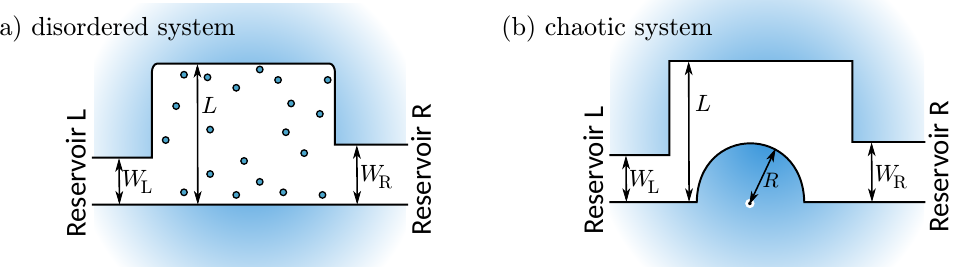
The systems we consider in this work are those described by random matrix theory, this could be (a) a disordered system or (b) a chaotic system (such as a Sinai billiard). In both cases, the system is coupled to two reservoirs (left and right) through leads with N and N modes respectively. The number of lead modes L R + N N for a lead of width W is given above Eq. (12b). We define N = N , and i i L R consider the properties of the ensemble of such systems for N (cid:29) 1, as modelled by an ensemble of random matrices. In the case of the disordered system, this ensemble corresponds to the ensemble of systems with the disorder in different positions. In the case of chaotic systems, this ensemble corresponds to an ensemble of shapes of the potential; for the Sinai billiard, such an ensemble can be found by varying the radius R over a range much larger than the particle wavelength but much smaller than the system